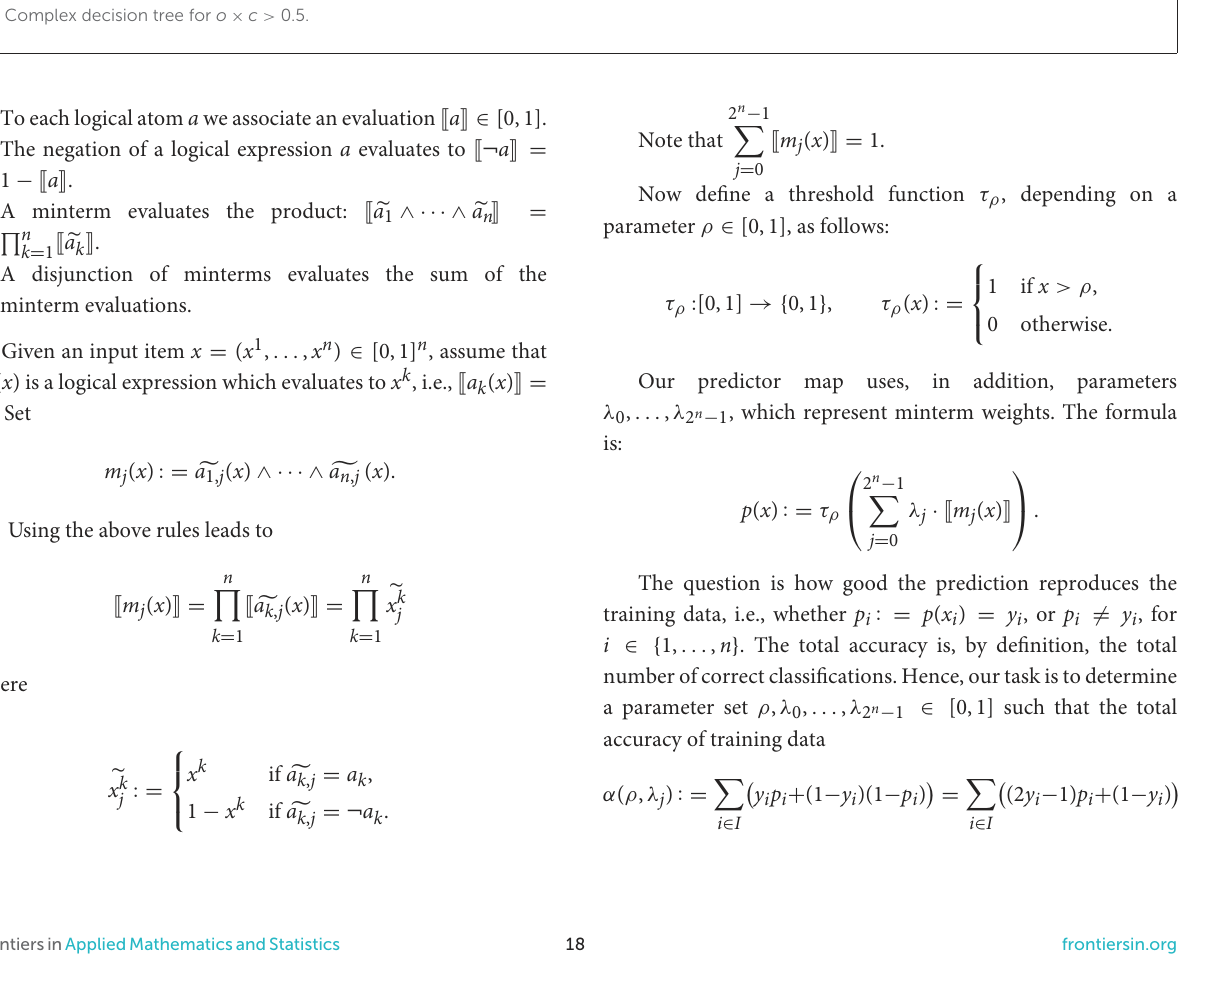
FIGURE5 Complex decision tree for o × c >